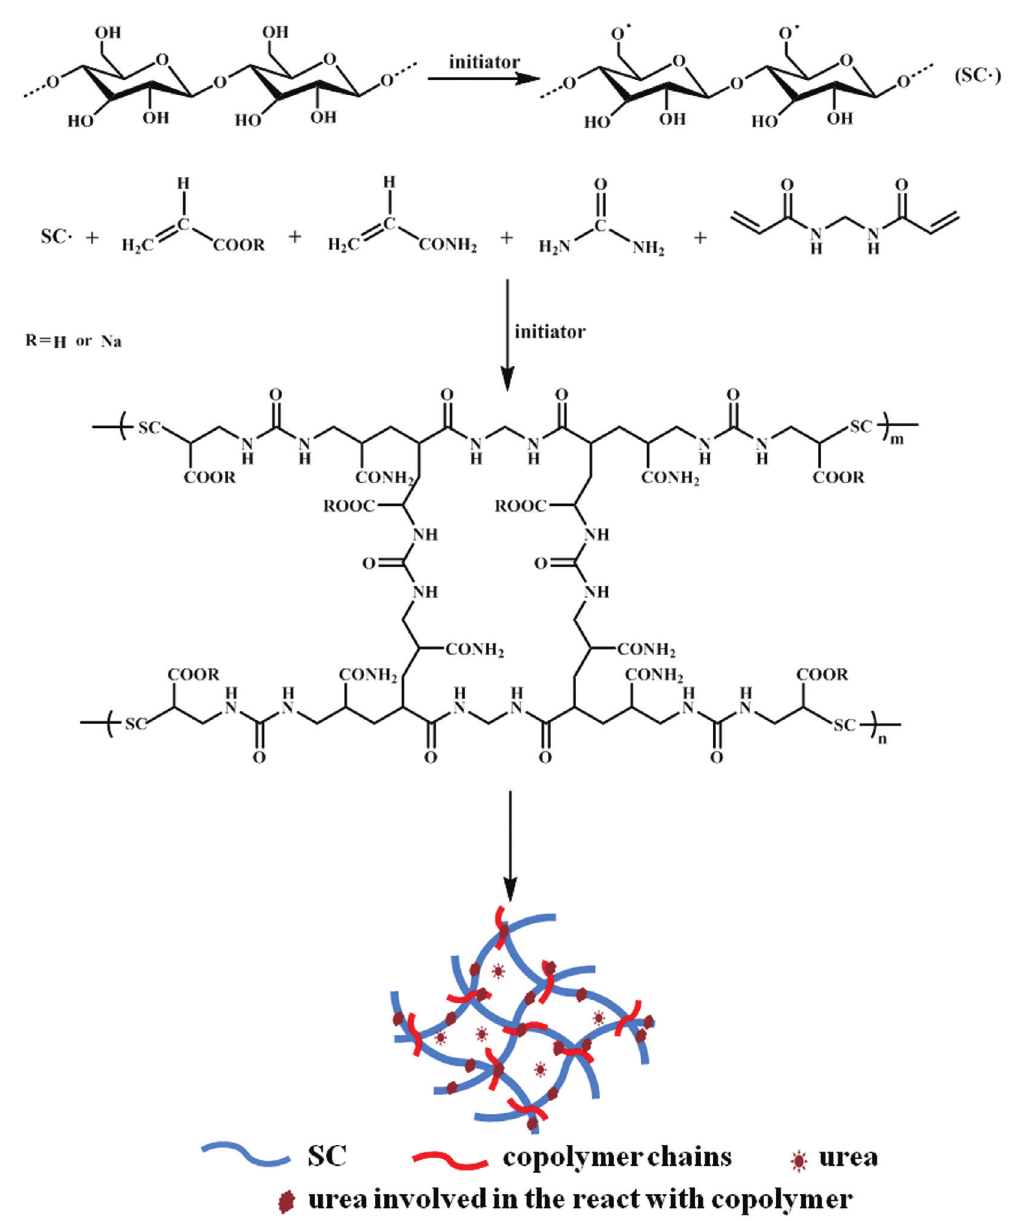
Scheme 1: The preparation scheme of